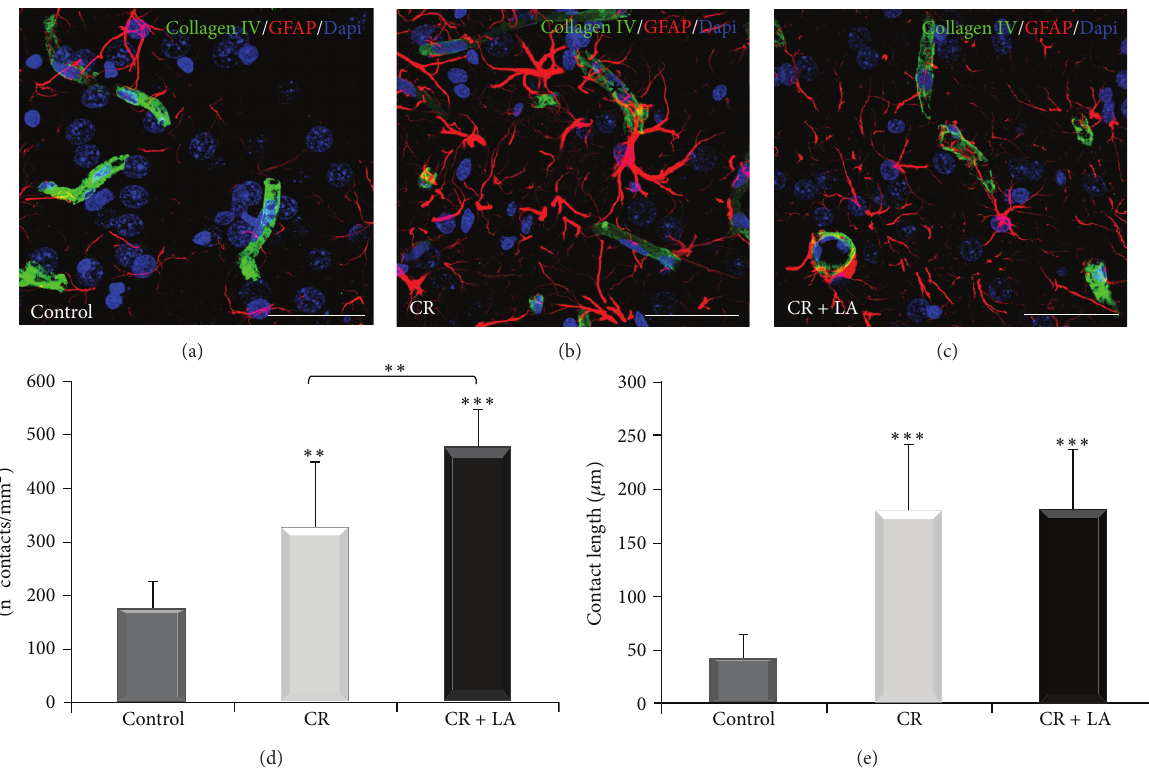
Figure 3: Immunofluorescence for GFAP (astrocytes in red) and Collagen IV (blood vessels in green) in control animals (a), nontreated animals (b), and LA treated animals (c) Nuclei become evident with Dapi (blue). Quantification of the density of contacts (n ∘ contacts/mm 2 ) established between astrocytes and blood vessels (d) and the total length of the contacts ( 𝜇 m). (e) Scale bar: 20 𝜇 m. ∗∗ 𝑃 < 0.01 ; ∗∗∗ 𝑃 < 0.001 . with ImageJ 1.44i for Mac. The quantifications were per- formed in the first 500 𝜇 m from the injury limit. Six images were randomly taken of 4 sections of each animal ( 𝑛 = 6 ) and the number of cells was determinate by the nuclei presence and referred to the total area quantified (n ∘ cells/mm 2